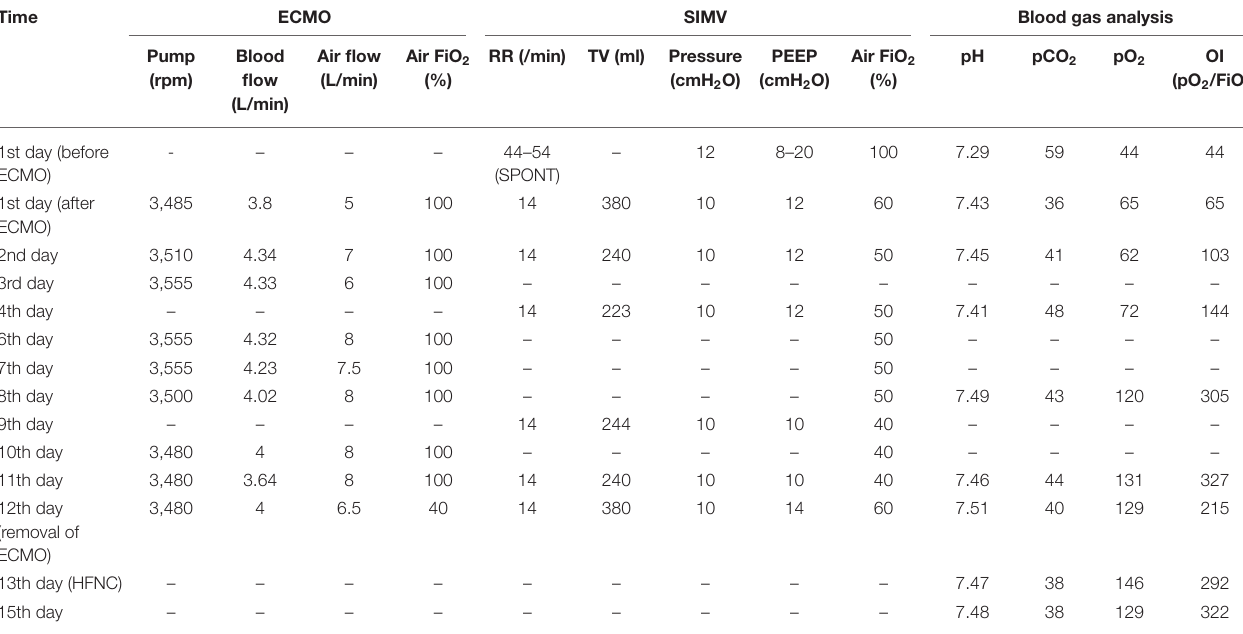
TABLE 1 | Extracorporeal membrane oxygenation (ECMO) and SIMV parameters and results of arterial blood gas analysis. Time